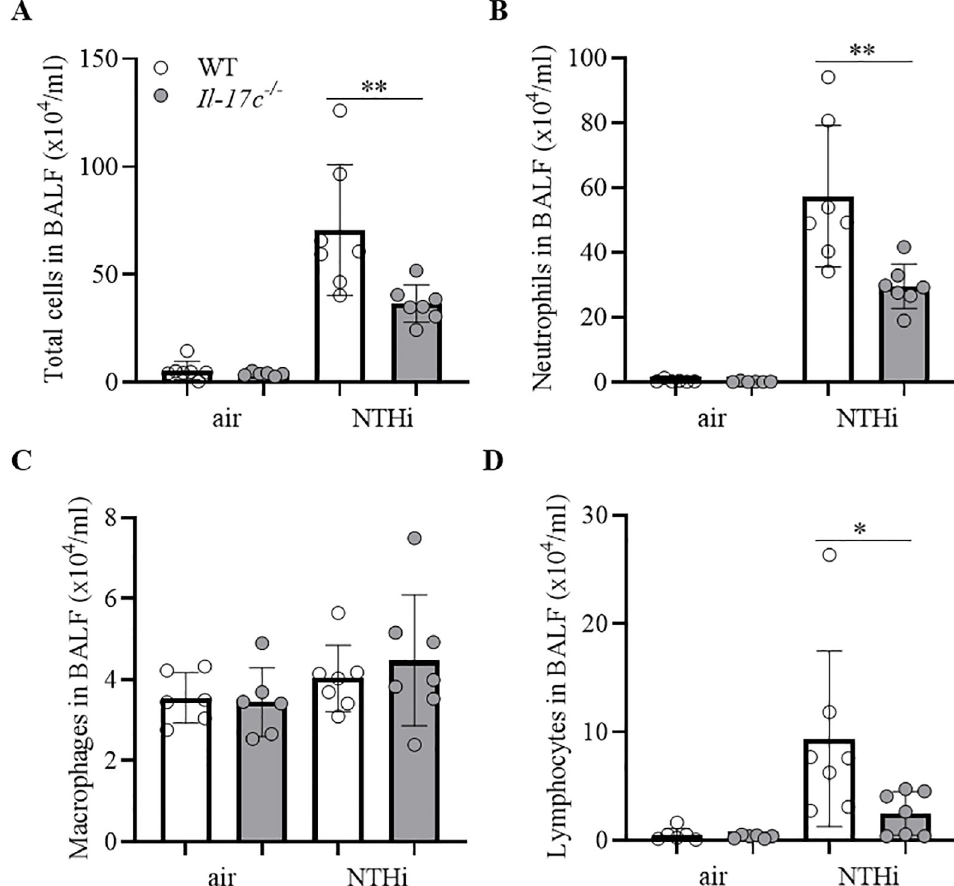
Fig 1. IL-17C mediates chronic neutrophilic inflammation. WT and Il-17c -/- mice were exposed to heat-inactivated NTHi three times a week (day 1, 3, 5) for 4 weeks. Numbers of total immune cells (A), neutrophils (B), macrophages (C), and lymphocytes (D) were determined in BAL fluids 24 hours after the final exposure to NTHi (n = 6–7 per group). Data were compared by One-way ANOVA with Bonferroni post-test and are shown as the mean ± SD. � p < 0.05 and �� p <